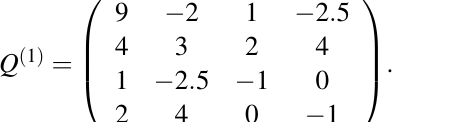
Fig.1. State curves x 1 ( t ) of system (24) with activation function